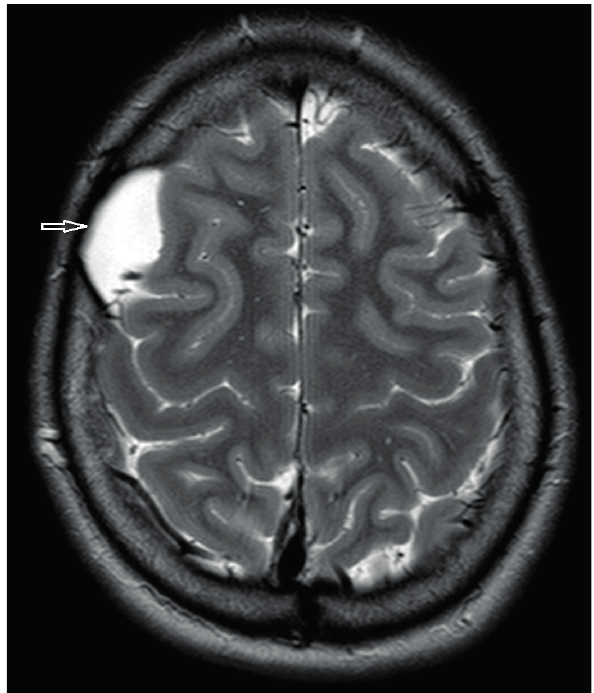
Fig. 2. Right-sided frontal arachnoid cyst in a 14-year-old autistic boy, MRI T2/TSE in the axial